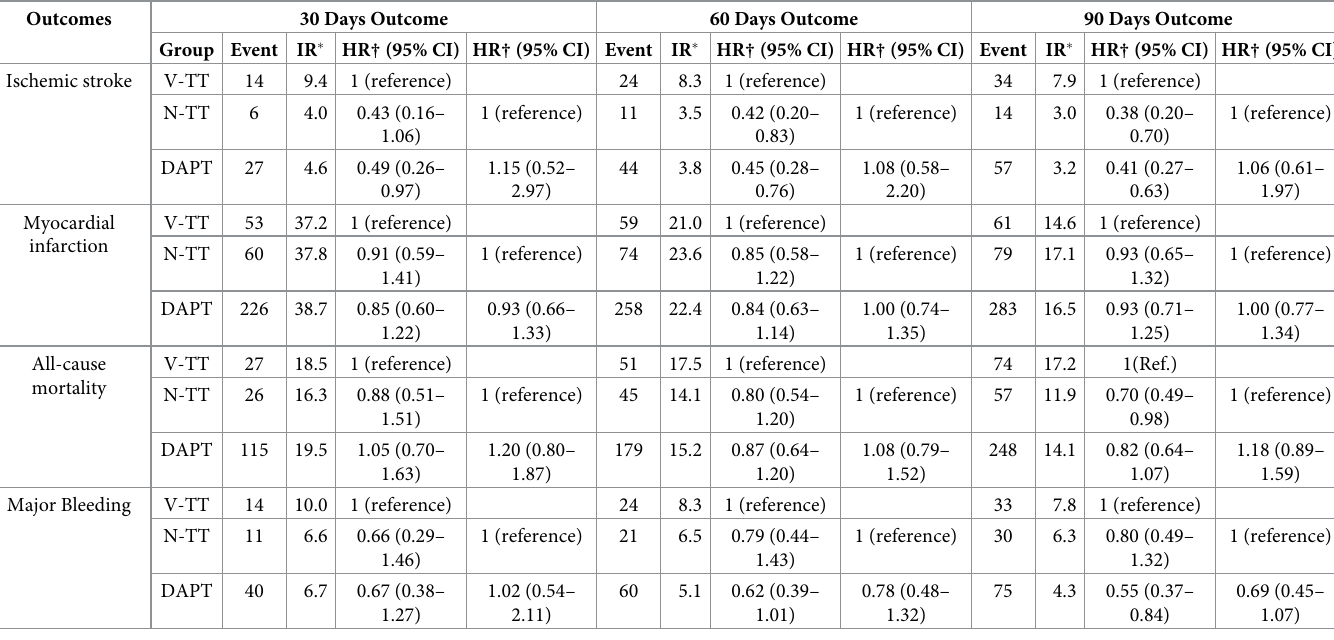
Table 2. Comparison of clinical outcomes according to antithrombotic therapy. Outcomes 30 Days Outcome 60 Days